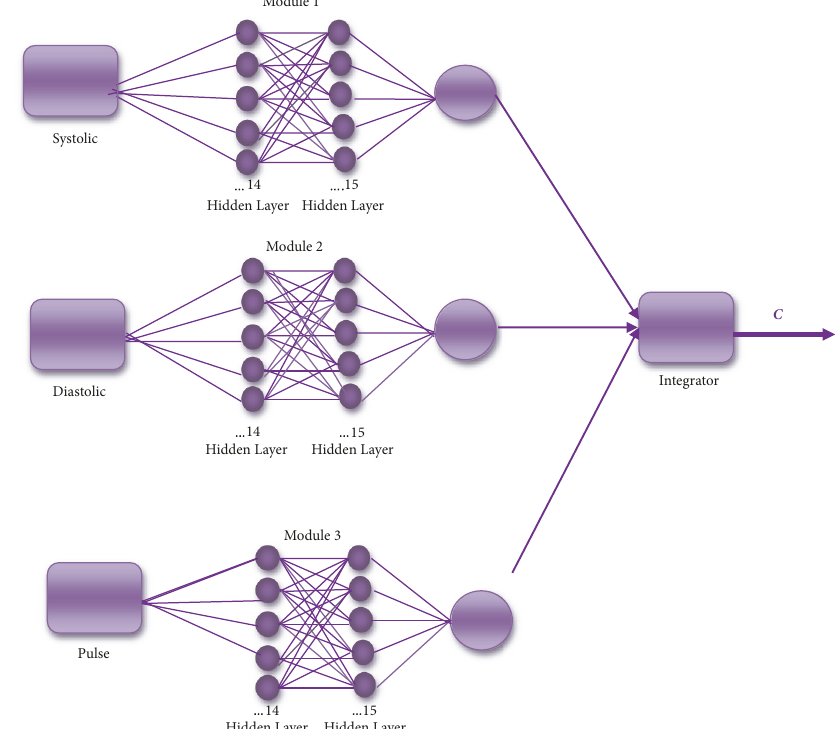
Figure 3: The best architecture for MNN with the training method (trainlm).